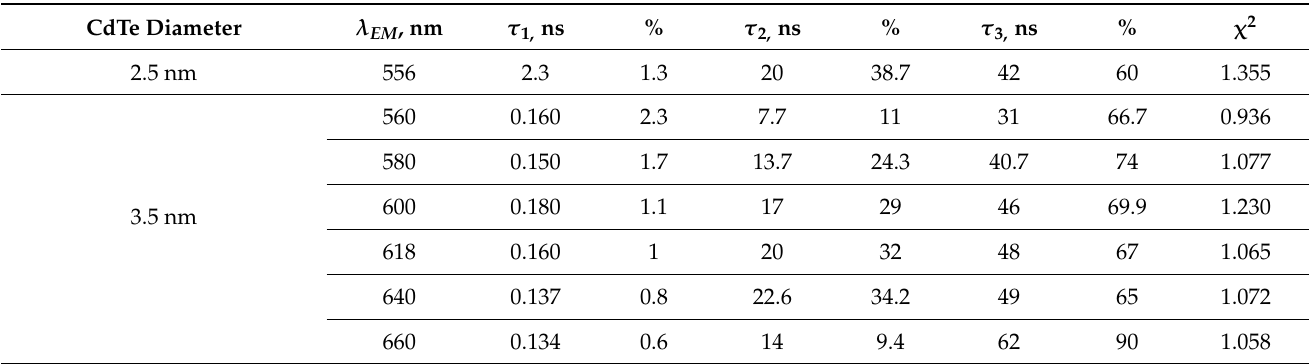
Table 4. PL lifetimes for aqueous dispersions of CdTe QDs depending on their diameter d and λ EM . λ e = 405 nm. T = 296